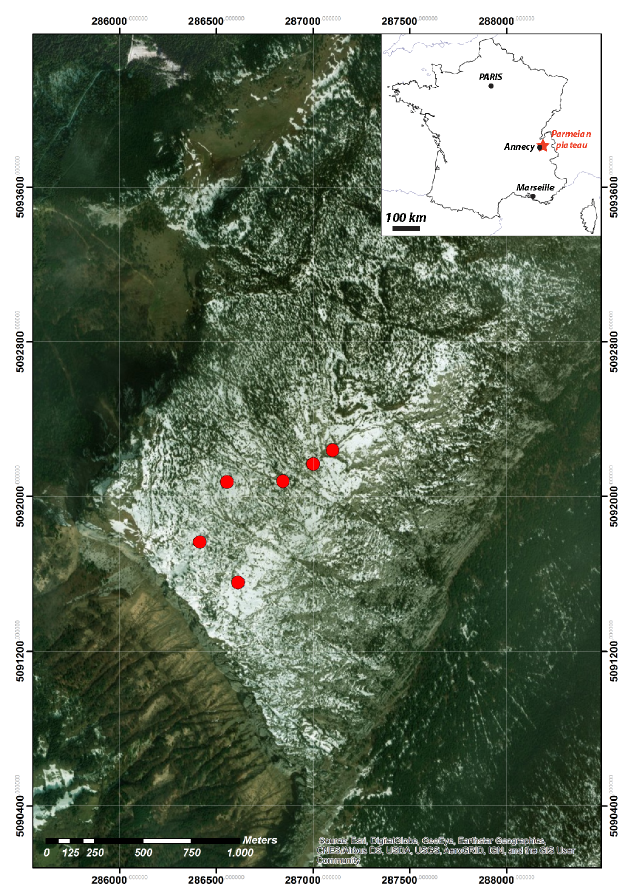
Figure 6. Location of the Parmelan plateau in France within the Bornes Massif depicting drone flight base points for six drone missions. This map was generated using satellite imagery ob- tained from ESRI World Imagery